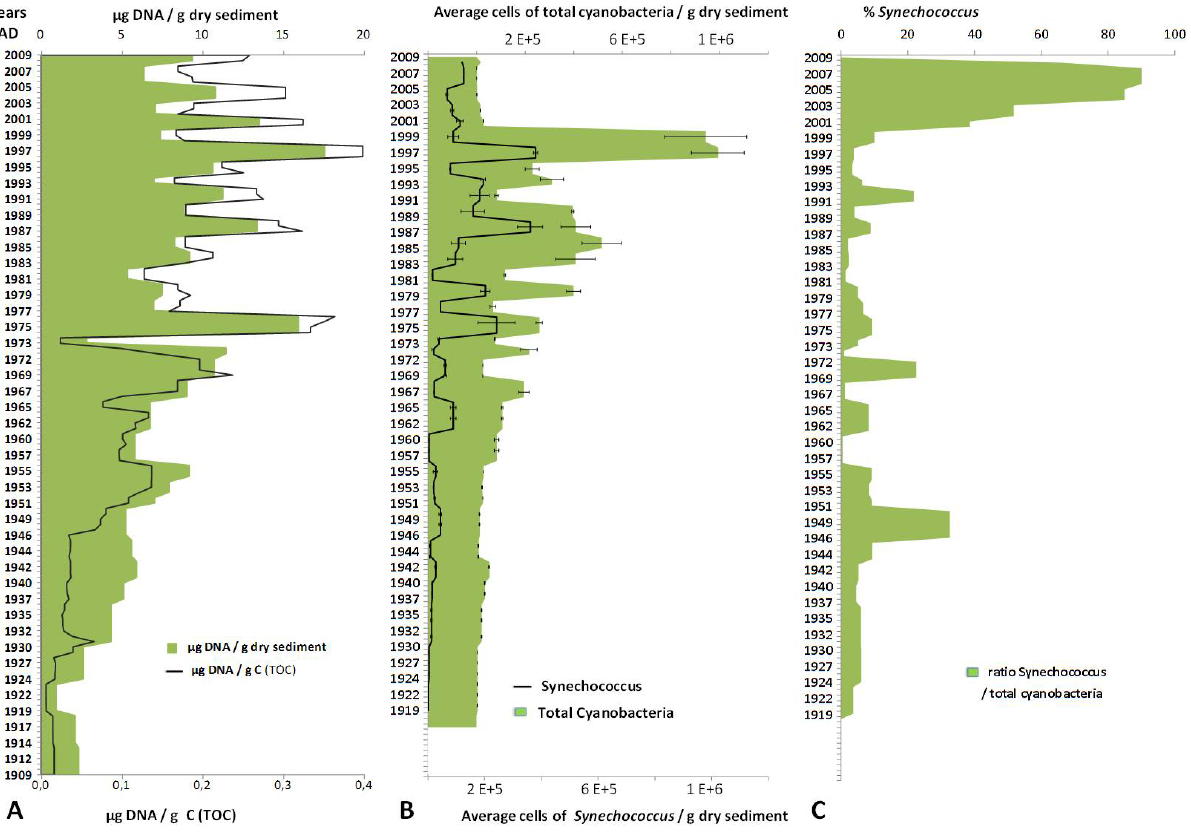
Fig. 2. Profile A shows the vertical distribution of extractable DNA quantities (µg per gram of dry sediment, and µg per gram of TOC). Profile B presents the abundances of total cyanobacteria (SG-rRNA-ITS) and Synechococcus (TNA-ITS), estimated by qPCR, in the sediment samples. Error bars, which are in some cases hidden by the symbols, give the standard deviations for three independent amplifications. Profile C presents the ratio of Synechococcus counts to total Cyanobacteria counts (qPCR data).